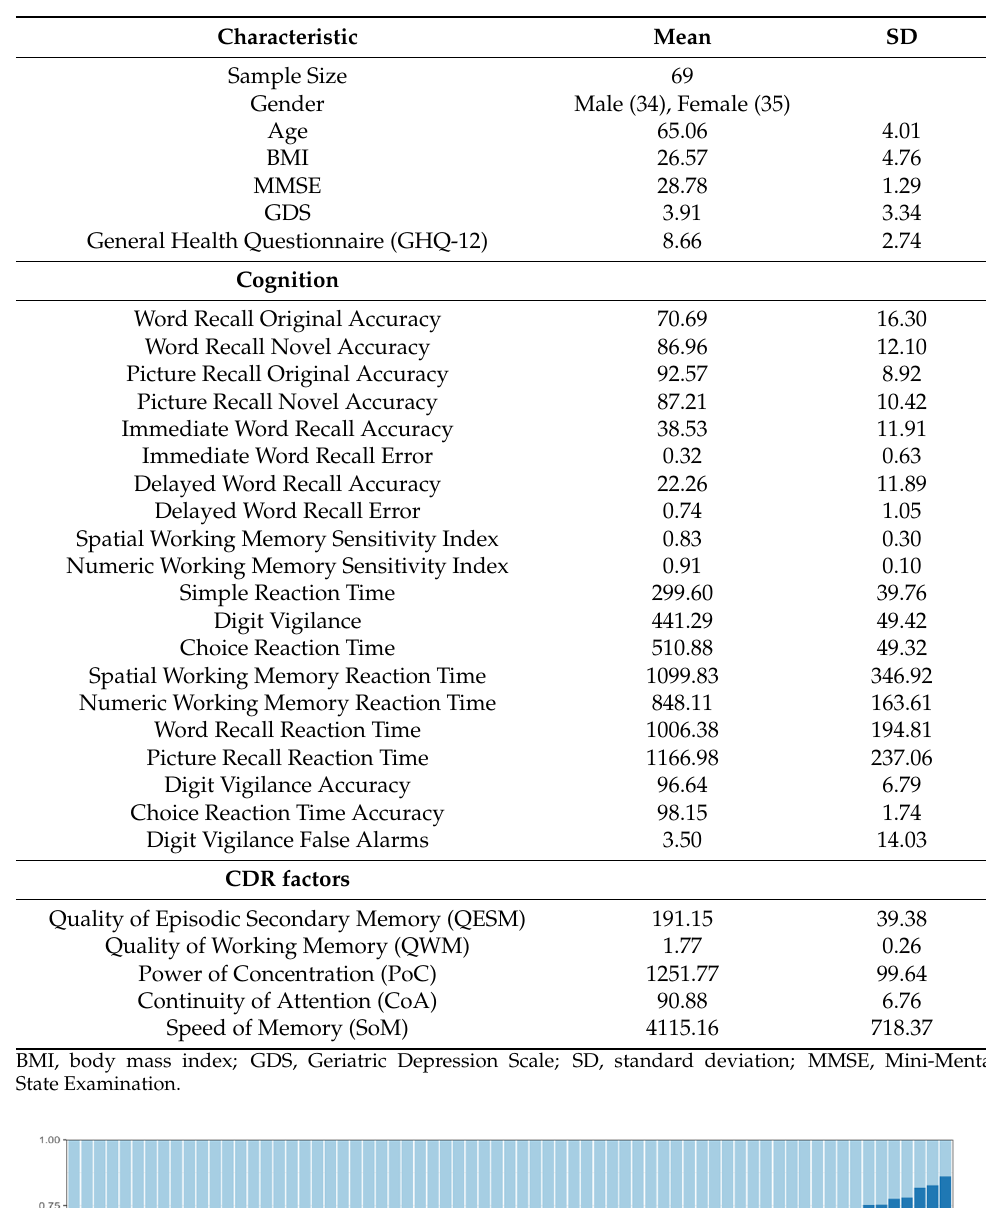
Table 1. Participant characteristics.